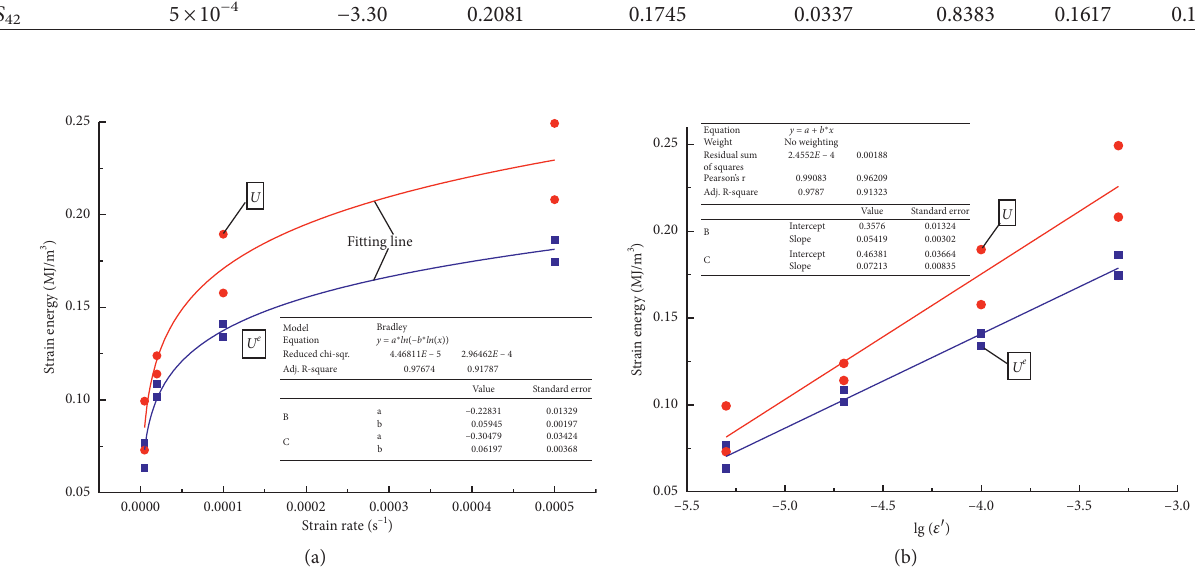
Figure 9: Relationship between strain energy and strain